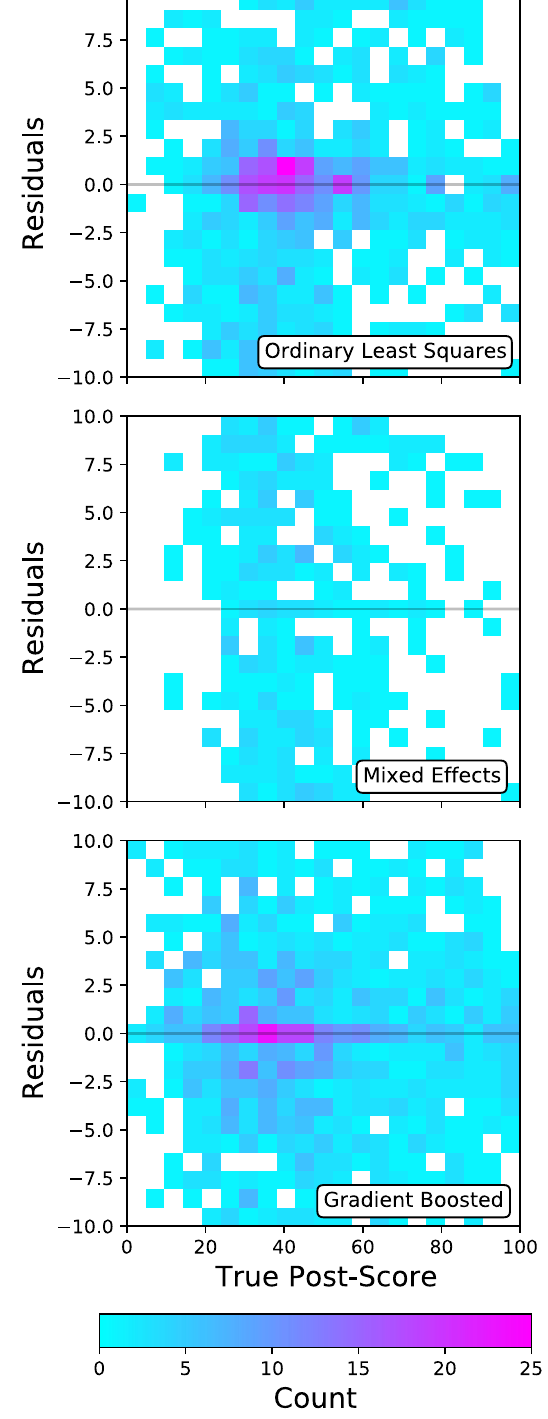
FIG. 4. Residuals plots for the LASSO study. For the OLS model and the xgboost model, the residuals are normally distributed with the majority being within (cid:3) 10 points of the true value (see Appendix Fig. 6). The mixed effects model does not produce normally distributed residuals.